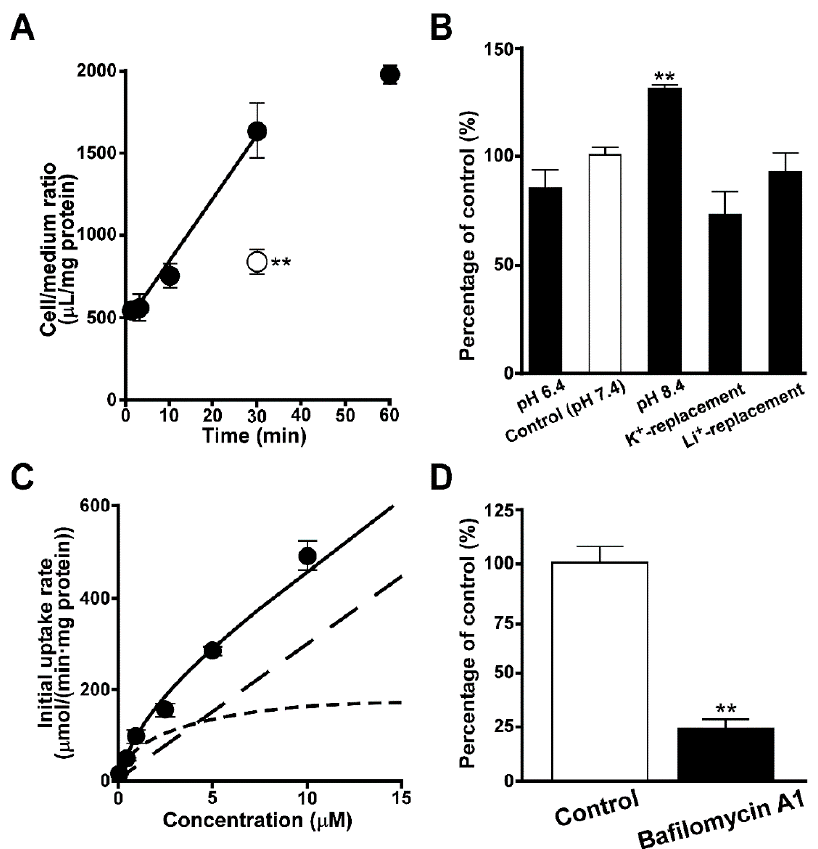
Figure 1. Quinacrine uptake by TR-iBRB2 cells. ( A ) Time-dependent uptake of quinacrine (5 μ M) by TR-iBRB2 cells was investigated at 37 °C (closed circles) and 4 °C (open circles). ( B ) The effects of Na + , extracellular pH and membrane potential were examined at 37 °C for 30 min. ( C ) Concentration- dependent uptake was examined at 37 °C for 30 min, over the concentration range 1-10 μ M. Dotted and dashed lines represent a saturable and non-saturable transport process, respectively. ( D ) The effects of bafilomycin A1 was examined. Before quinacrine uptake at 37 °C for 30 min, cells were treated with 100 nM bafilomycin A1 at 37 °C for 30 min. Each column and point represent the mean ± S.E.M. (n = 3–4). Significant difference for two groups and for several groups was taken using an unpaired two-tailed Student’s t-test was taken for two groups and a one-way analysis of variance (ANOVA) followed by Dunnett’s test, respectively. ** p < 0.01, significantly different from the control (37 °C, pH 7.4).